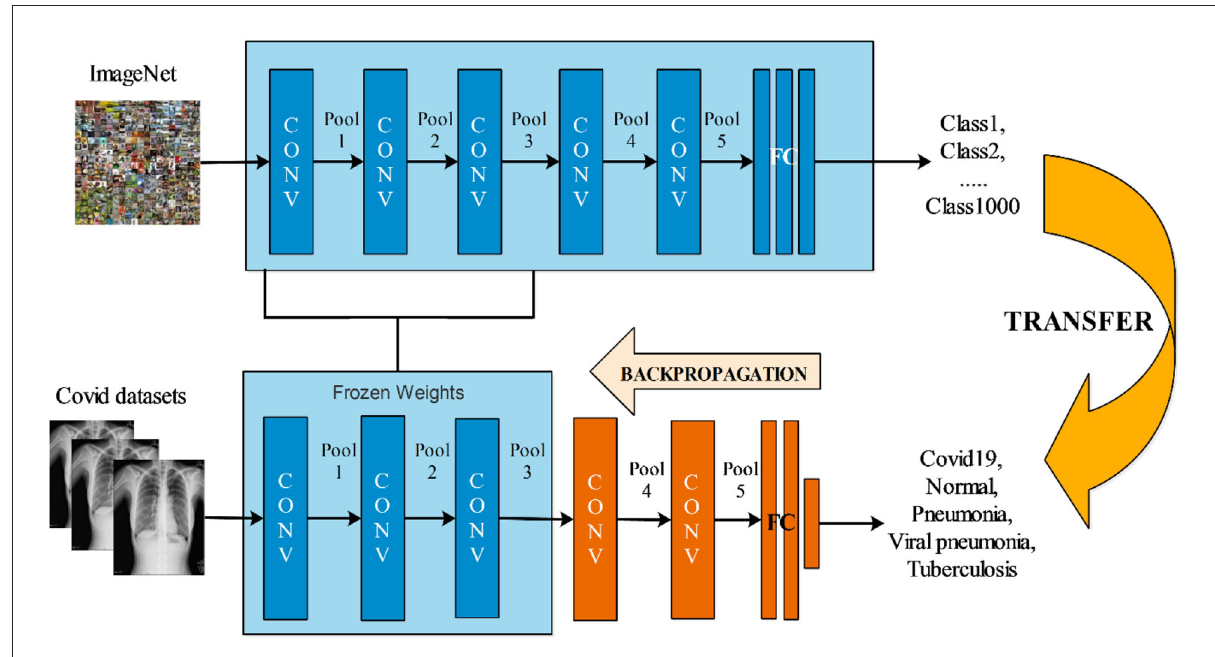
FIGURE4 Visual process of transfer learning for the training of fine-tuned deep models.